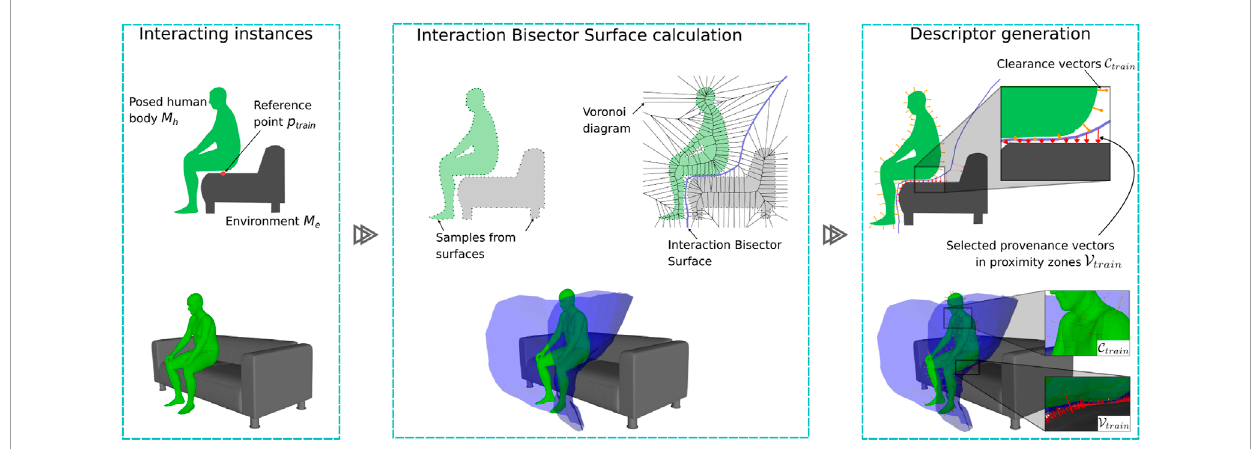
FIGURE 2 2D and 3D illustrations of our one-shot training pipeline. (Left) Posed human body M h interacting with an environment M e on a reference point p train . (Center) Only during training, we calculate the Voronoi diagram with sample points from both the environment and body surfaces to generate an IBS. (Right) We use the IBS to characterize the proximity zones and the surrounding space with provenance and clearance vectors. A weighted sample of these provenance and clearance vectors, V train and C train , respectively, results in good generalization of the interaction.